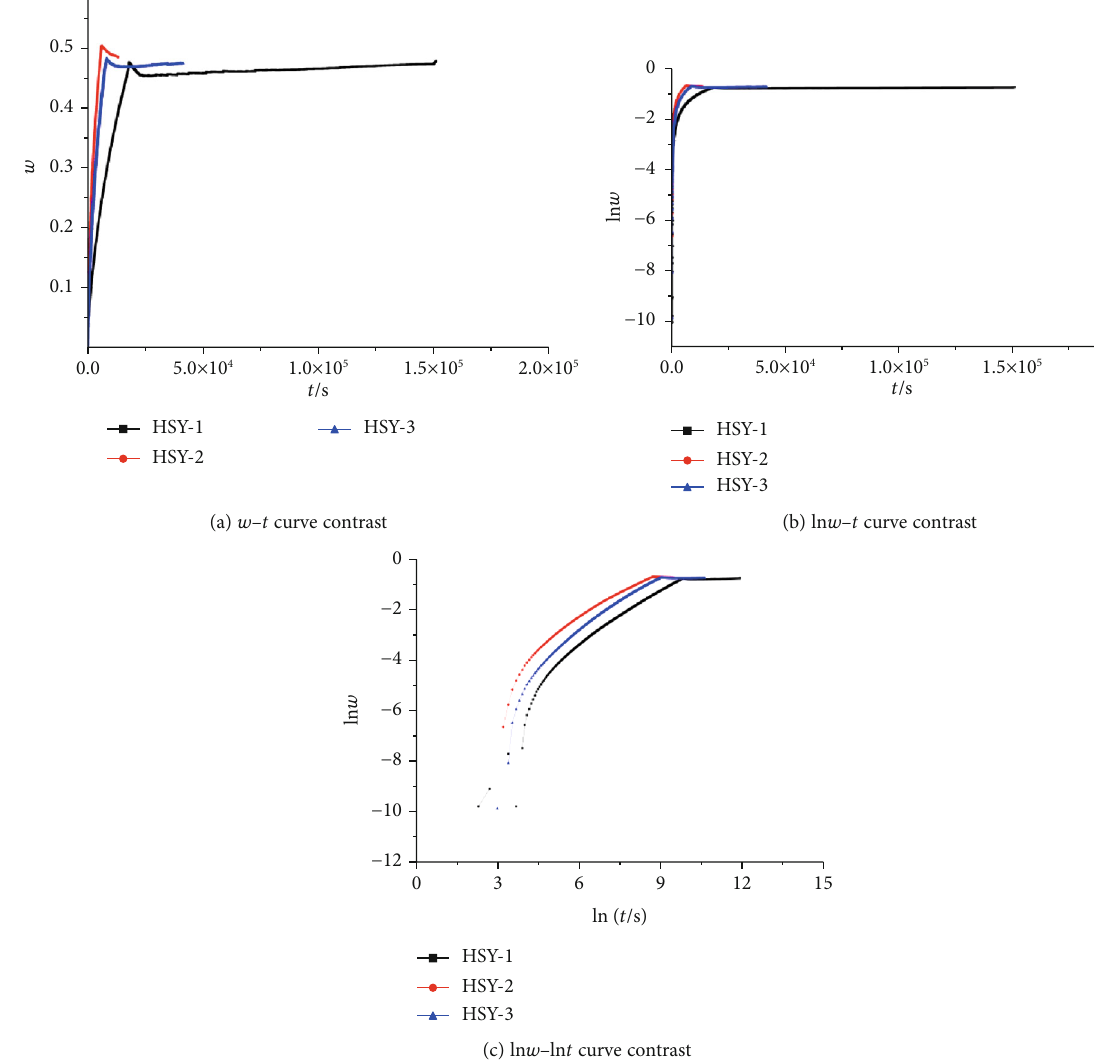
Figure 16: Correlation curves of black sandstone samples.